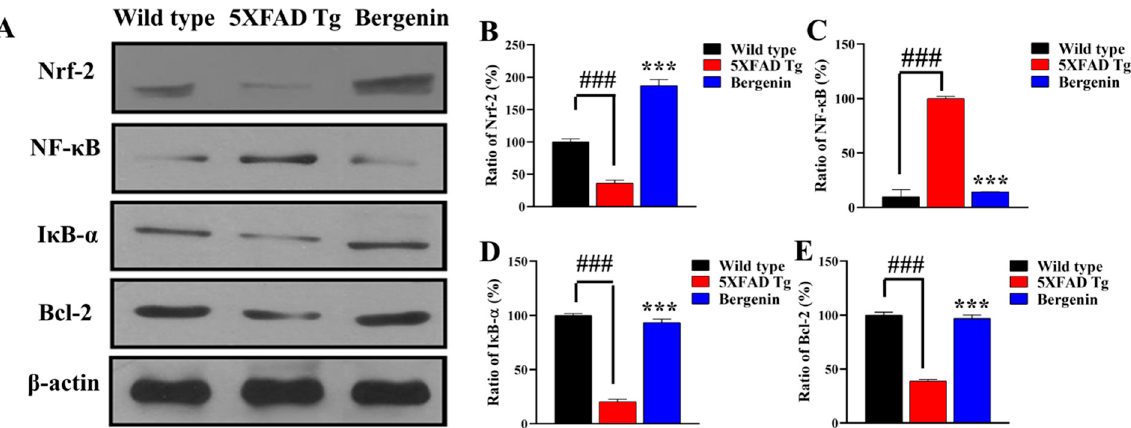
Figure 8. ( A ) Western blot analysis in the hippocampal regions of mouse brains for Nrf-2, NF- κ B, I κ B- α , and Bcl-2 proteins in wild-type, 5xFAD Tg and Bergenin-treated groups. ( B – E ) Represents quantitative analysis of target proteins expressing the ratio of percentage (%) production. Scale bar = 50 µm. Results were expressed as mean ± S.D. *** p < 0.001 versus the 5xFAD Tg group, ### p < 0.001 versus the wild-type group.